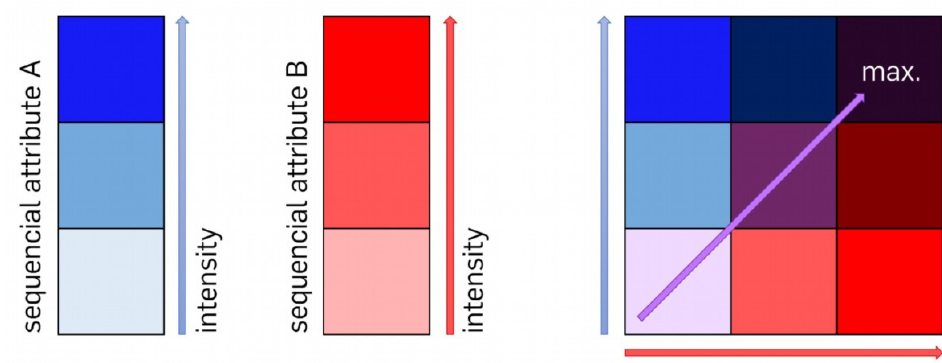
Figure 6. Schematic generation of a sequential matrix legend (Source: authors).